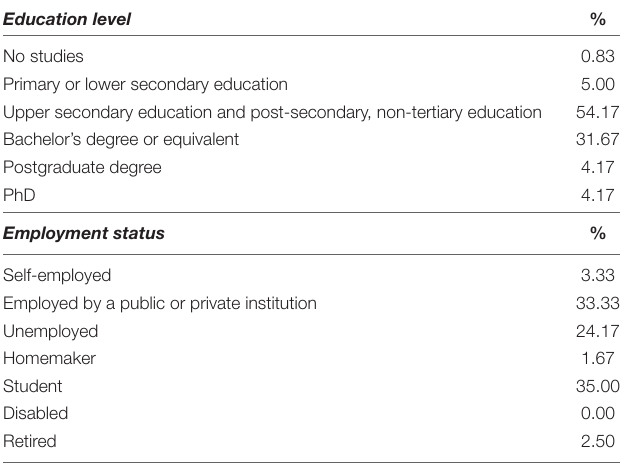
TABLE 1 | Sociodemographic characteristics of participants 1